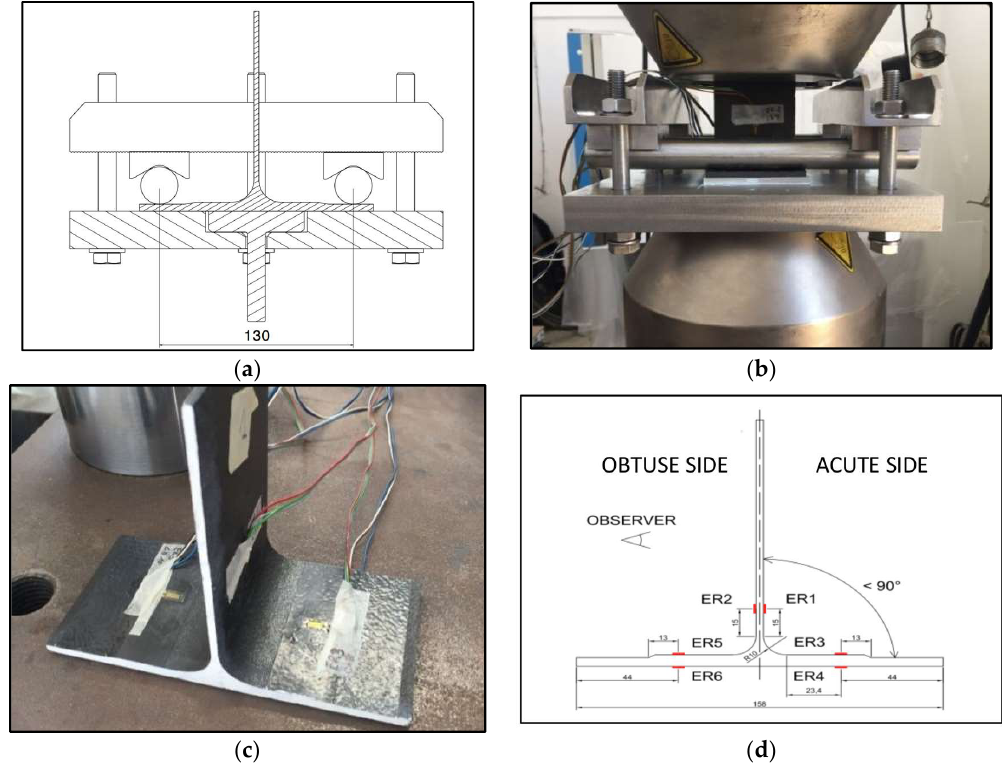
Figure 5. ( a ) Geometry and ( b ) image of loading system; ( c ) T-Pull specimen and ( d ) strain gage